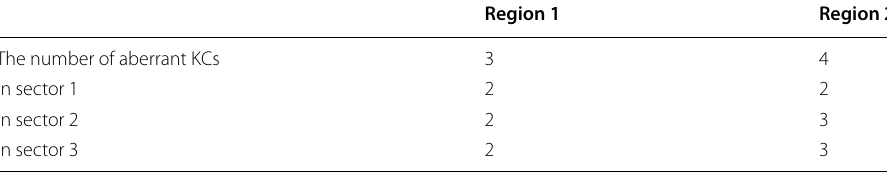
Region 1 Region 2